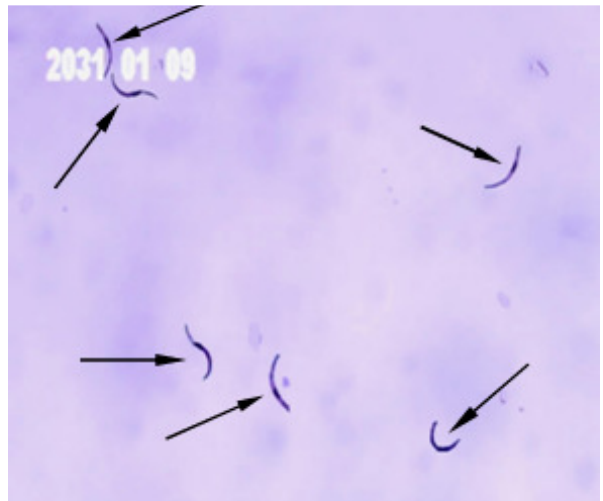
Fig. 1. Sporozoite stage of P. falciparum (spindle shaped and darkly stained) in the stained dissected salivary glands of an infective mosquito ( → shows P. falciparum sporozoite)